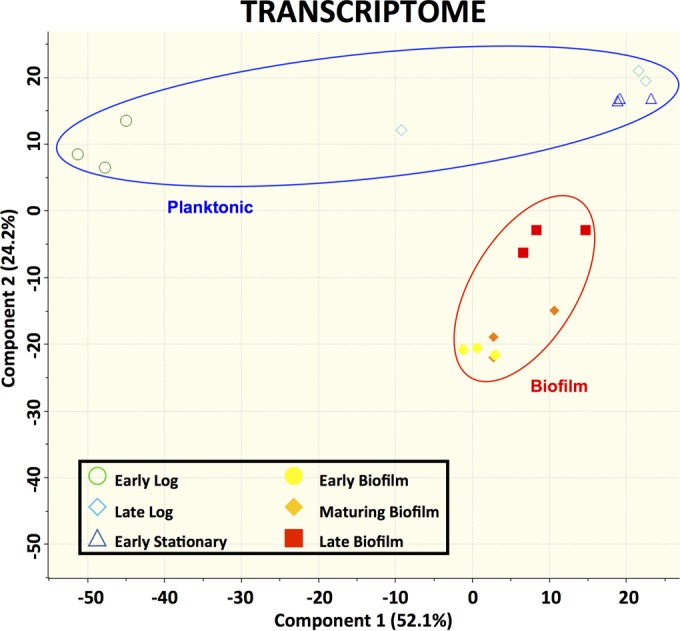
Clustering of biofilm and planktonic samples based on transcriptomic data. Data represent results of principal-component analysis (PCA) of log2 FPKM expression values from each sample. The PCA plot represents 1,781 genes for which expression values were available. Biological triplicates are shown by matching symbols.